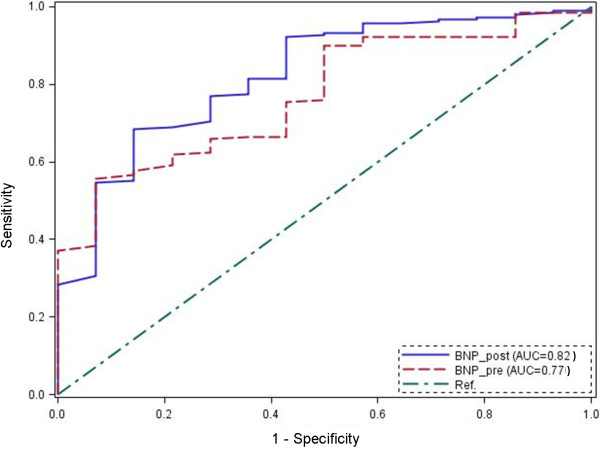
Receiver operating characteristic curve for preoperative (Preop.) and postoperative (Postop.) BNP levels and prediction of in-hospital MACE (major cardiac evets). AUC = area under the curve, Ref. = reference line.